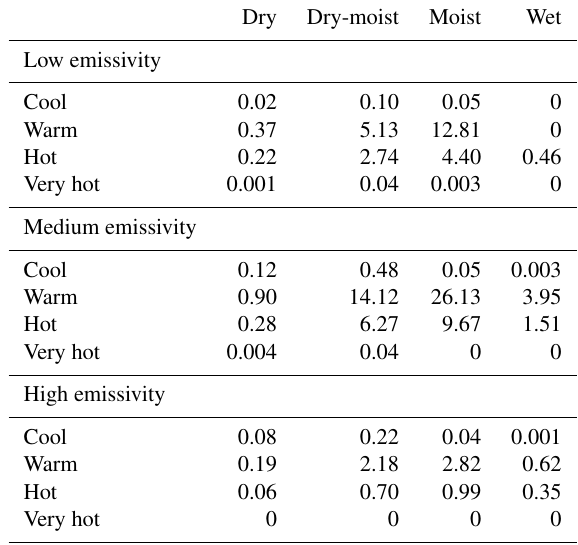
Table 5. Percentages of simulated emissivity– T skin –moisture occur- rence within the thick dust AOD range (from 2 to 3) and within Layer 2 (1–2km); ranges are as specified in Table 2. The total of all values listed here is 100%. Dry Dry-moist Moist